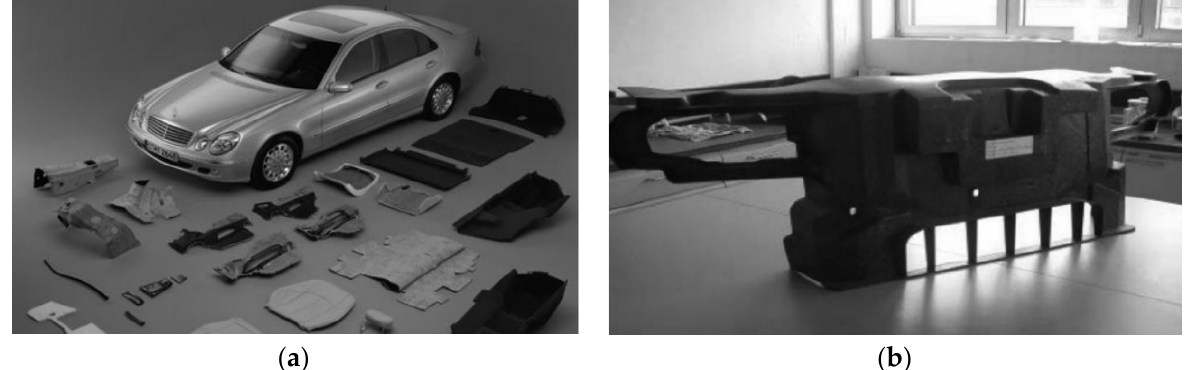
Figure 6. Natural composites applied in the automotive sector ( a ) Components of Mercedes-Benz E-Class ( b ) Ford Montagetrager front-end grill (available under a Creative Commons license [26]).